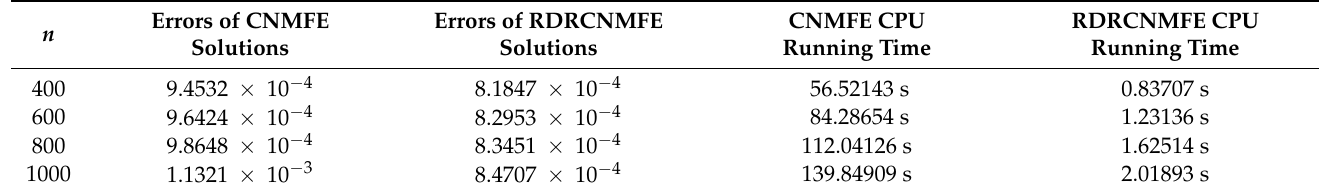
Table 1. The errors of the CNMFE and RDRCNMFE solutions and CPU running